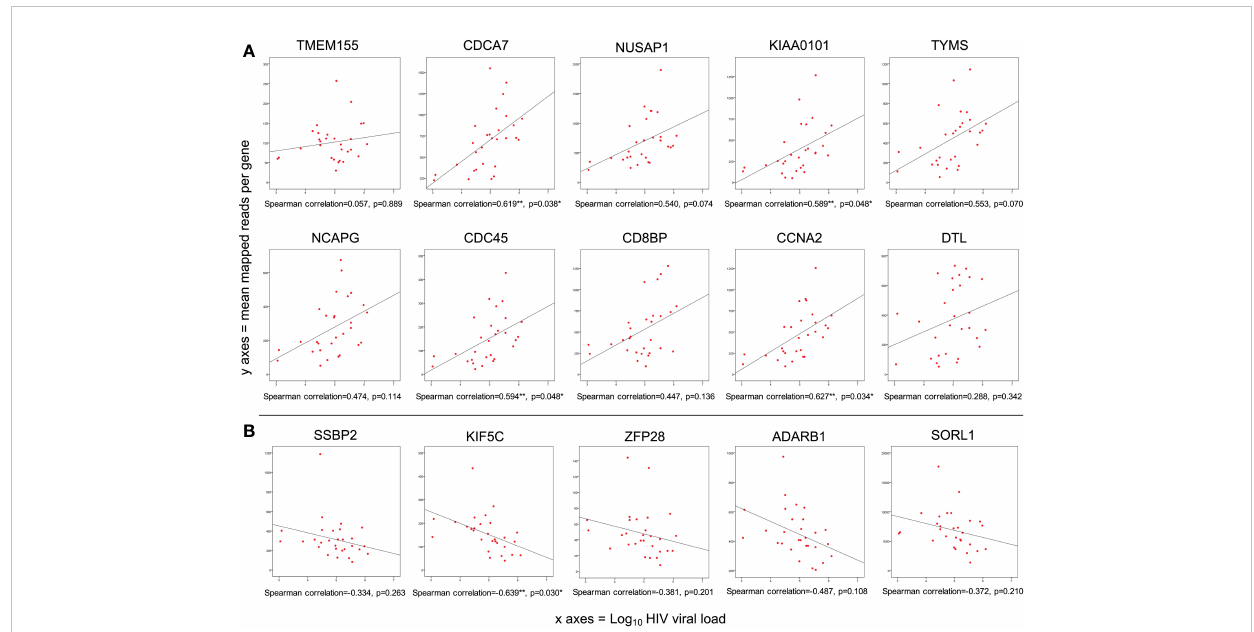
FIGURE 3 Of genes differentially expressed during acute HIV infection, 1.6% were correlated with viral load. (A) Spearman correlation of Log 10 HIV viral load with mean mapped reads of the top ten upregulated genes; (B) Spearman correlation of Log 10 HIV viral load with mean mapped reads of the top fi ve downregulated genes. p<0.05; **p<0.01; ***p<0.001 (FDR adjusted).